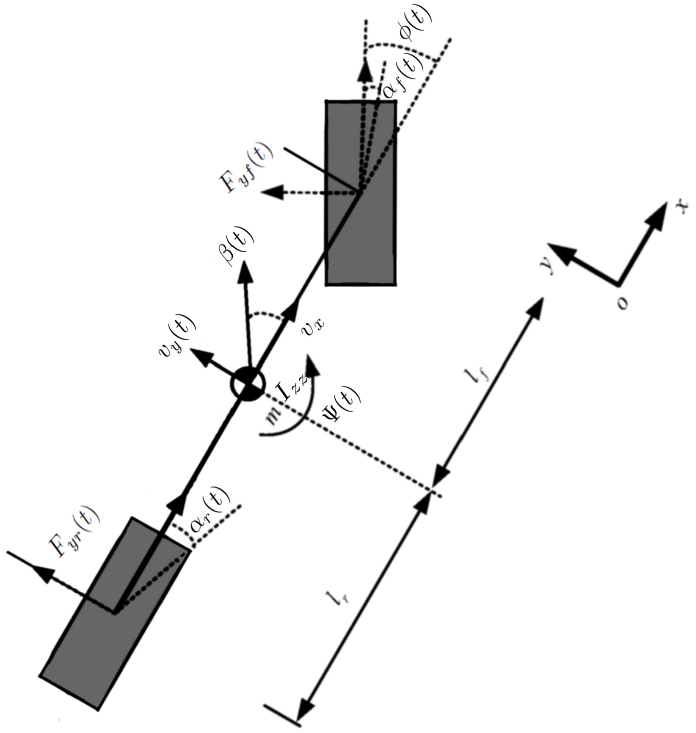
Figure 2. Single-track